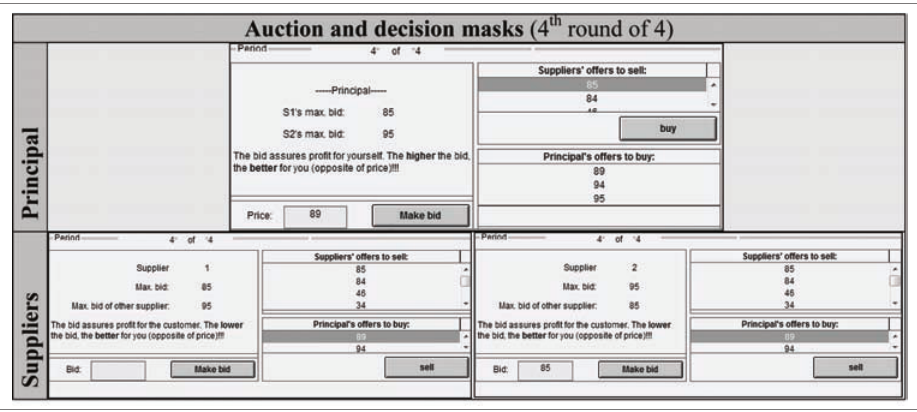
Fig. 2. 2-step initial bargaining: irrevocable determination of the supplier, profit division with him